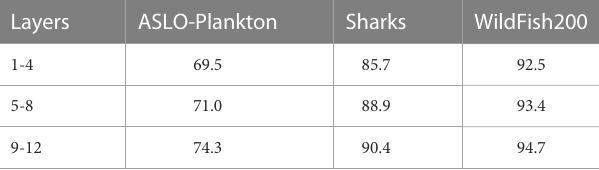
TABLE 5 Ablation experiments on the number of selected tokens.